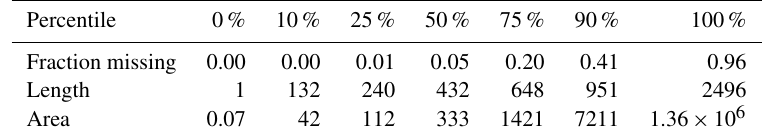
Table 1. Percentiles of selected statistics of the monthly runoff database. Shown are the fraction of missing months (Fraction missing), the time series length in months (Length) as well as the catchment area in square kilometres (Area).